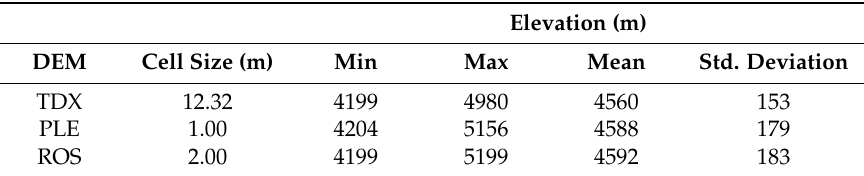
Table 3. Elevation ranges of different DEMs in the ROS domain.